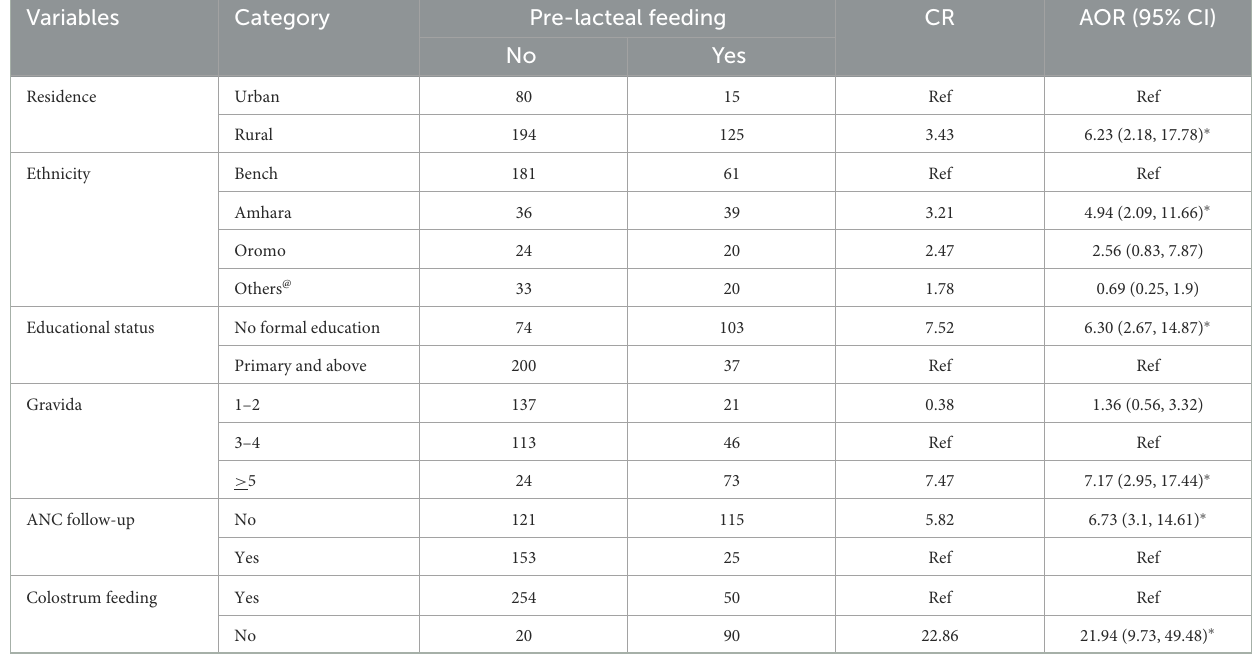
TABLE 5 Factors associated with pre-lacteal feeding among reproductive age women in southwest Ethiopia.